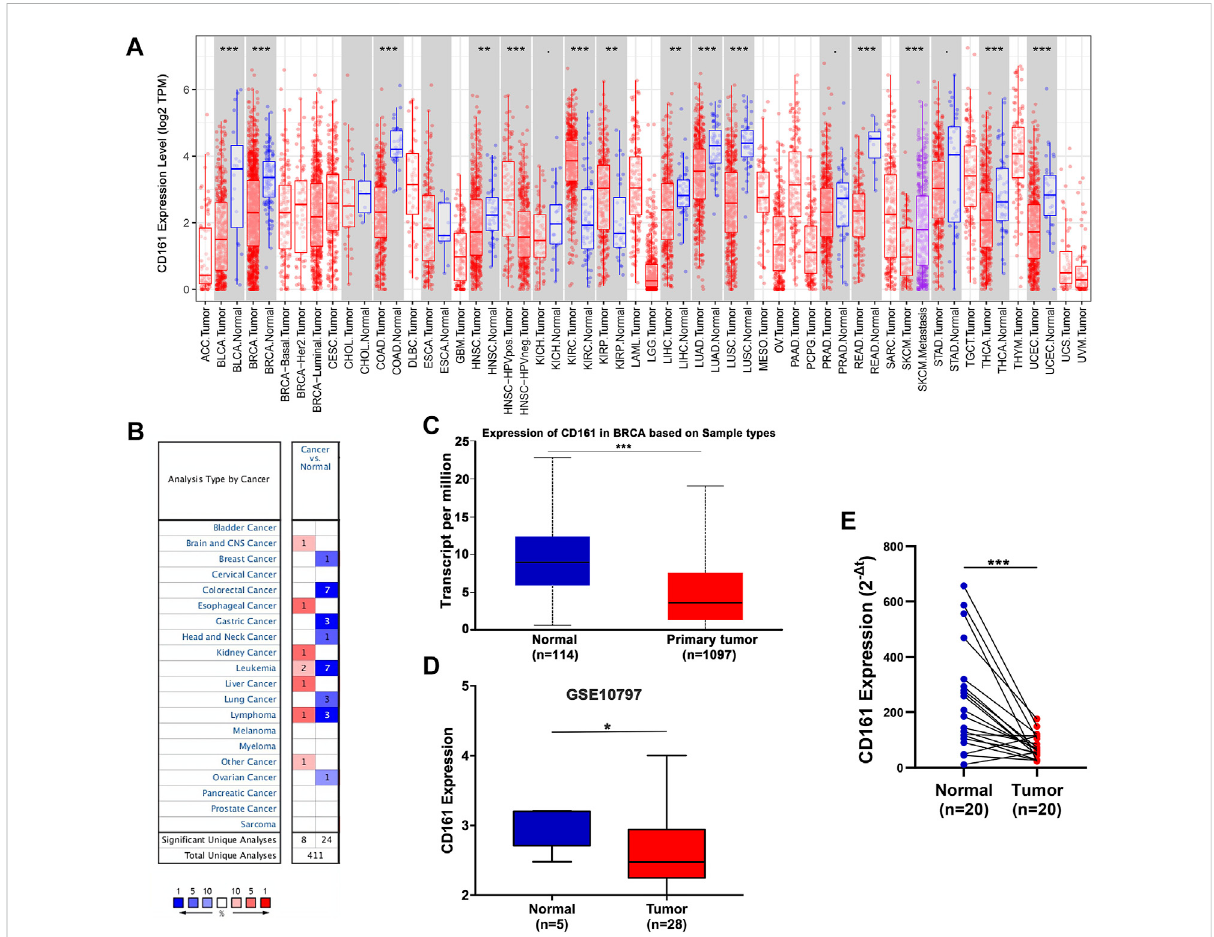
FIGURE 1 ThemRNA expression levelsof CD161 invarious humancancers. (A) Differential expression of CD161 betweenpaired tumorandnormal tissues in various human cancers from the TIMER database. (B) Meta-analysisof CD161 expression between paired tumor and normal tissues across various humancancersfromtheOncominedatabase. (C) Comparisonof CD161 expressionbetweenbreasttumorandnormalsamplesinUALCANdatabase. (D) Comparison of CD161 expression between breast tumor and normal tissues in GEO GSE10797 datasets. (E) qRT-PCR results of CD161 expression between paired breast tumor and normal tissue samples from our cohort, n = 20. GEO, Gene Expression Omnibus. * p < 0.05, ** p < 0.01, *** p <